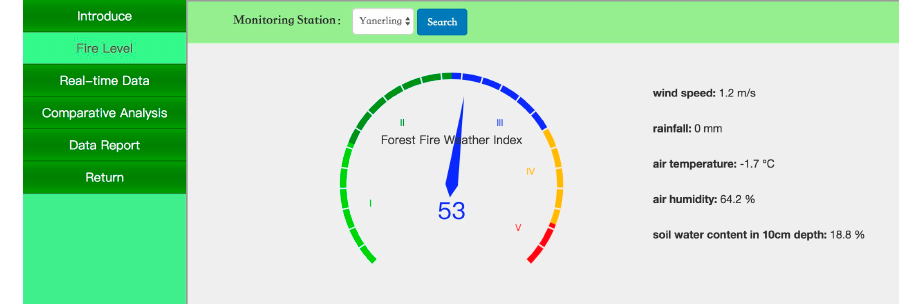
Figure 8. Local forest fire weather grade under the forest microclimate.